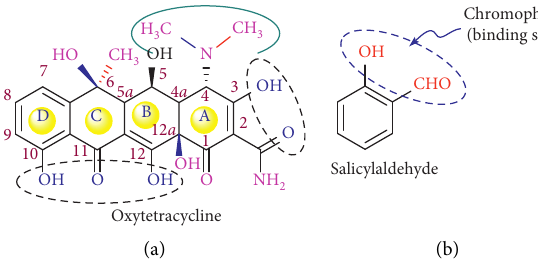
Figure 1: Structure of (a) oxytetracycline and (b) salicylaldehyde.